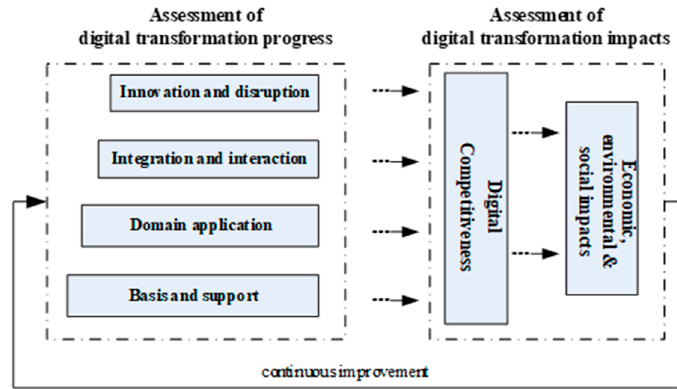
Figure 1. Assessment framework of enterprises’ digital transformation. According to the assessment framework, a set of assessment indicators with three levels are shown in Figure 2.